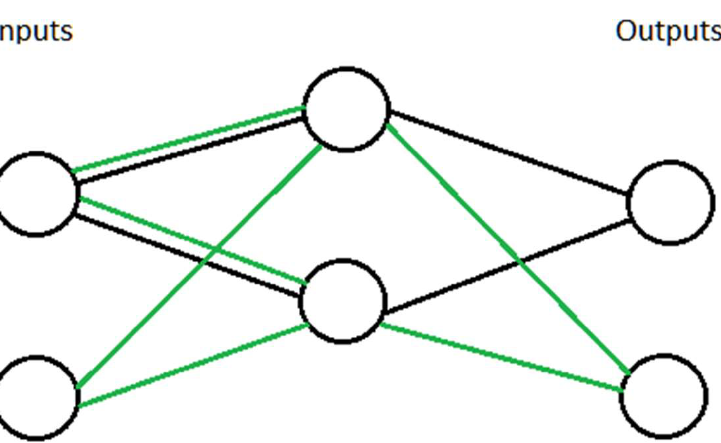
Figure 3. Abstract diagram of neurons and their connections. Two neural circuits are represented, one with connections shown by black lines, and the other by green lines. The information flow in this neural system is from input neuron to output neuron. Only a single neural circuit is activated at a time, and its activation is dependent on specific environmental conditions. Therefore, the neurons may be recorded as having different roles if there is not an experimental control on the environmental